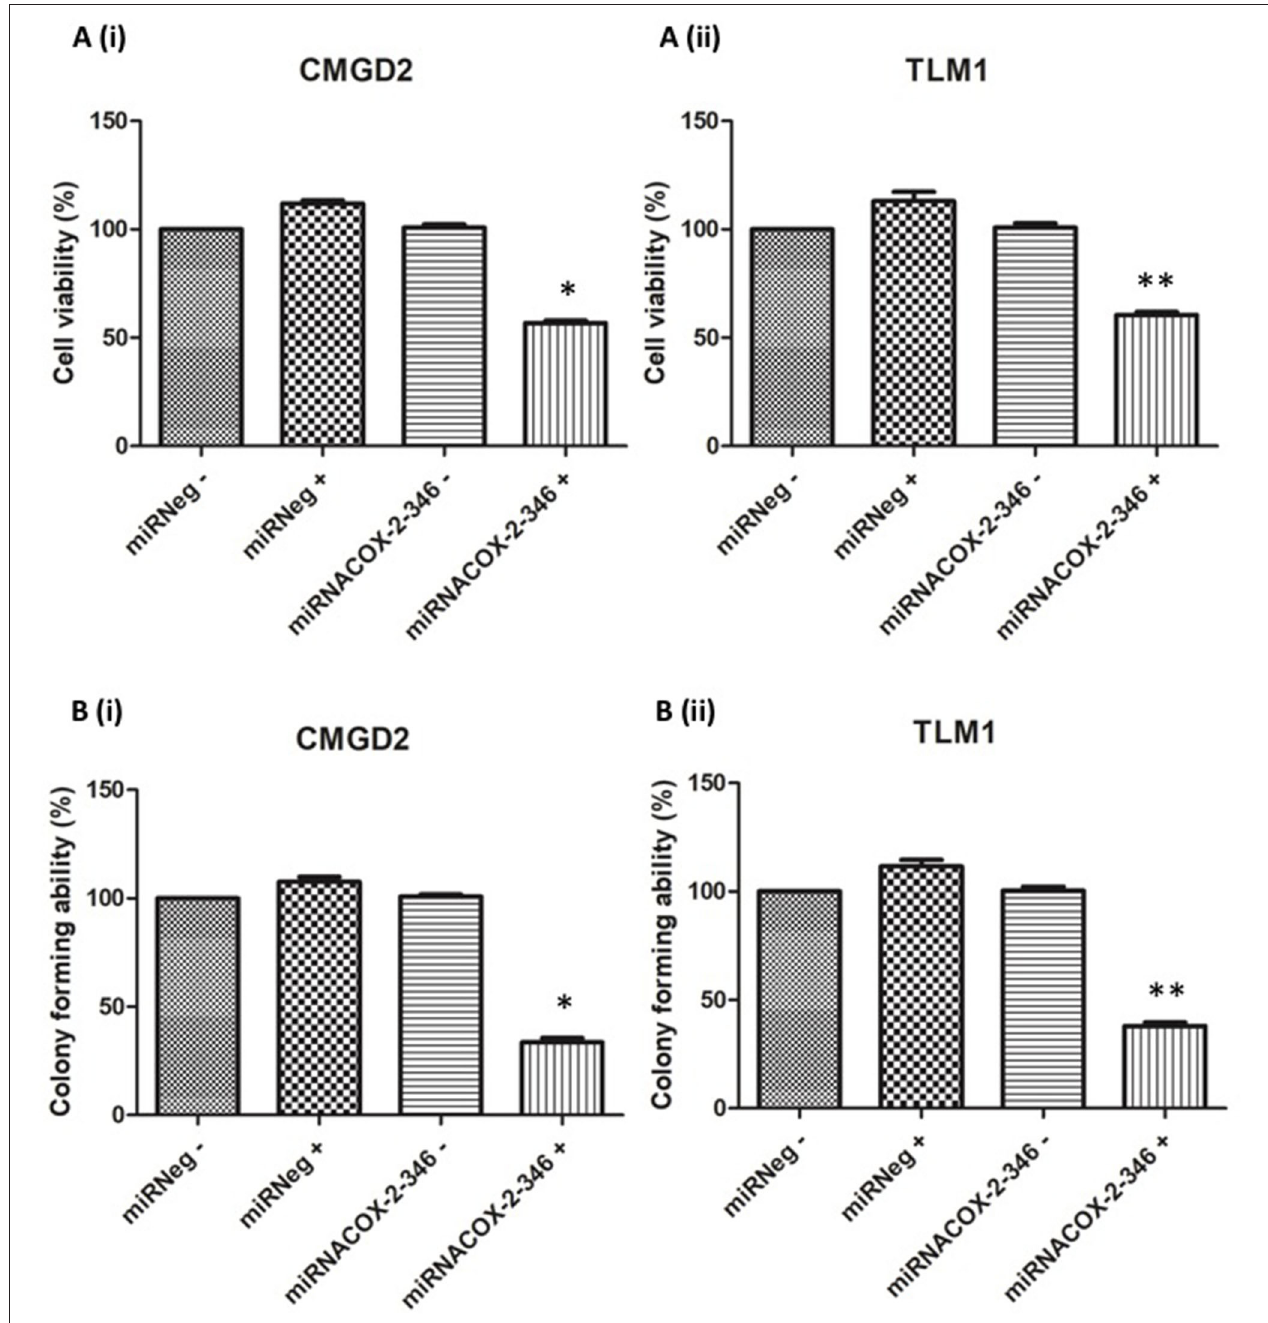
FIGURE 3 | Melanoma cell viability and colony-forming ability is COX-2 dependent. (A) Cell viability of CMGD2 (i) and TLM1 (ii) was determined after transfection with either miRNACOX2-346 or the miRneg negative control with ( + ) or without (–) DOX. Cell viability was assayed 48h after DOX treatment ( p = 0.001*, p = 0.003**). (B) Colony forming ability of CMGD2 (i) and TLM1 (ii) was determined after transfection with either miRNACOX2-346 or the negative control with ( + ) or without (–) DOX ( p = 0.0001*, p =